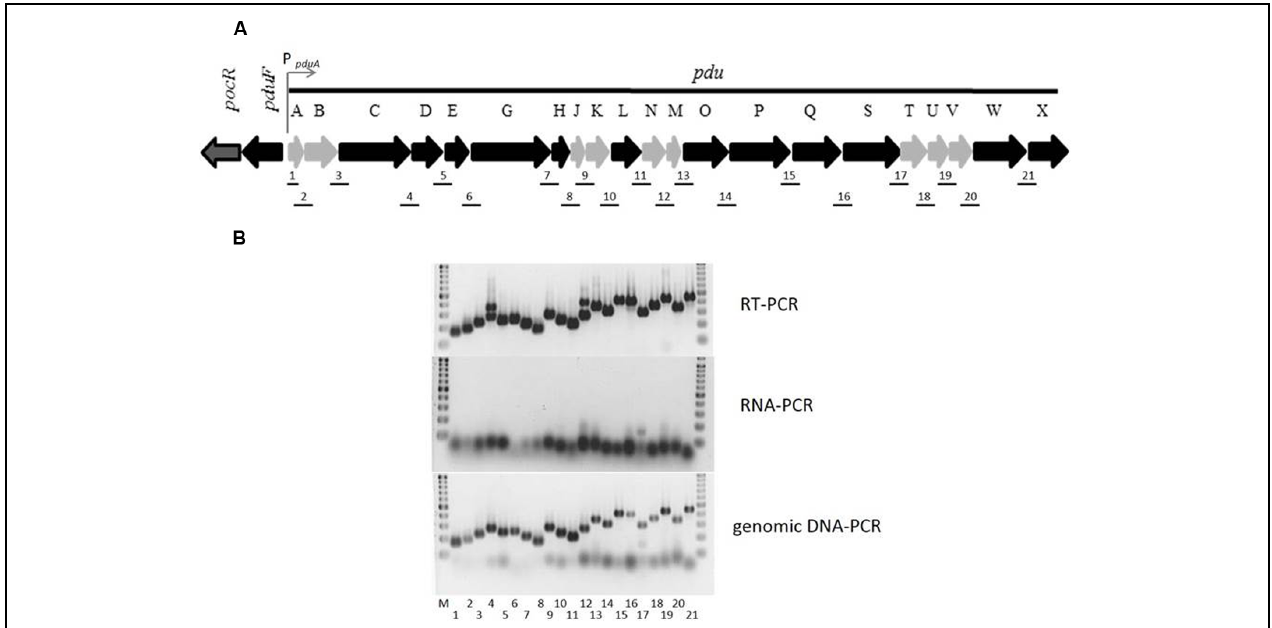
FIGURE 1 | Genomic organization and transcription of the pdu operon in Salmonella enterica serovar Typhimurium ( S. Typhimurium) strain 14028. (A) The pdu genes coding for proteins with enzymatic function are colored in black, and genes-encoding proteins contributing to the formation of the microcompartment-like polyhedral body are shaded in gray. The promoter P pduA is indicated with an arrow upstream of pduA. (B) Transcription of the pdu operon. For RNA isolation, strain 14028 was grown aerobically in VB-NCE-YE medium supplemented with trace elements, cobalamin, and 50 mM 1,2-PD to an OD 600 of 2.0. An aliquot of 100 ng of cDNA obtained by reverse transcription of RNA was used as a template for RT-PCR. Genomic DNA (100 ng) of strain 14028 served as a positive control, and total RNA (100 ng) as a negative control. Line numbers match the PCR product numbers in (A) . GeneRuler TM DNA ladder mix (Thermo Scientific) was used as a marker (M). The resulting fragments were separated on 2% (w/v) agarose